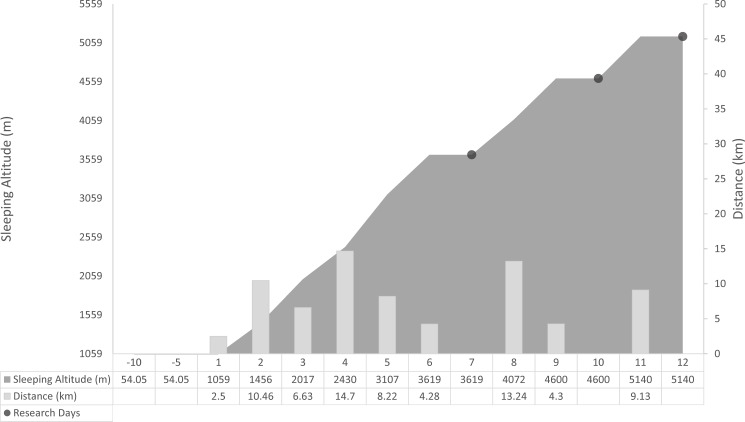
Trek itinerary and altitude profile.Daily trekking distance and sleeping altitude profile for participants utilized in this research.